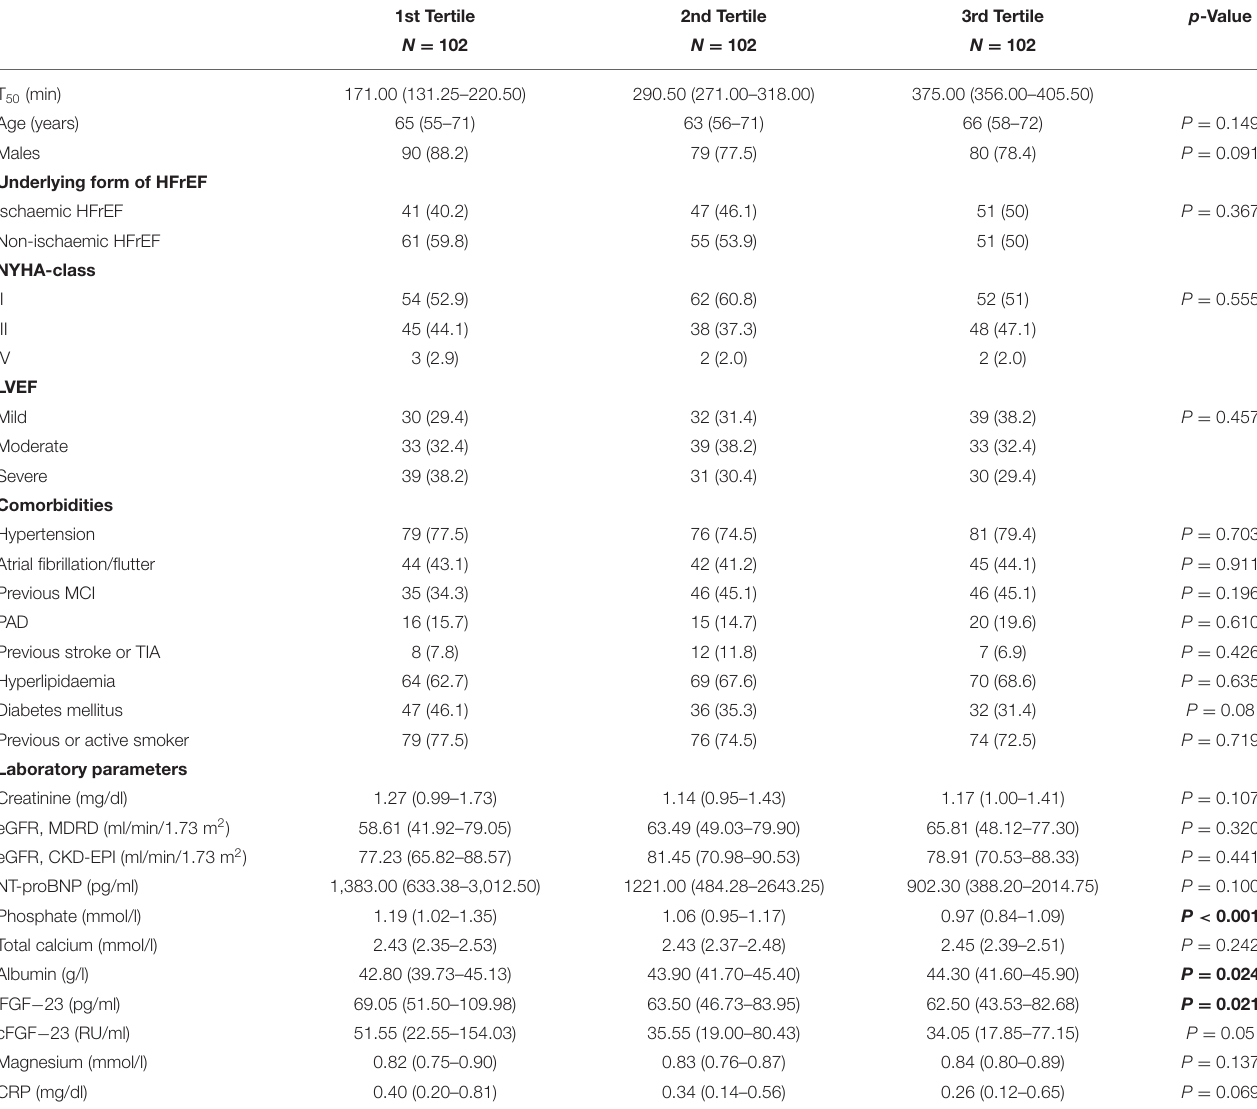
TABLE 1 | Basic characteristics by T 50